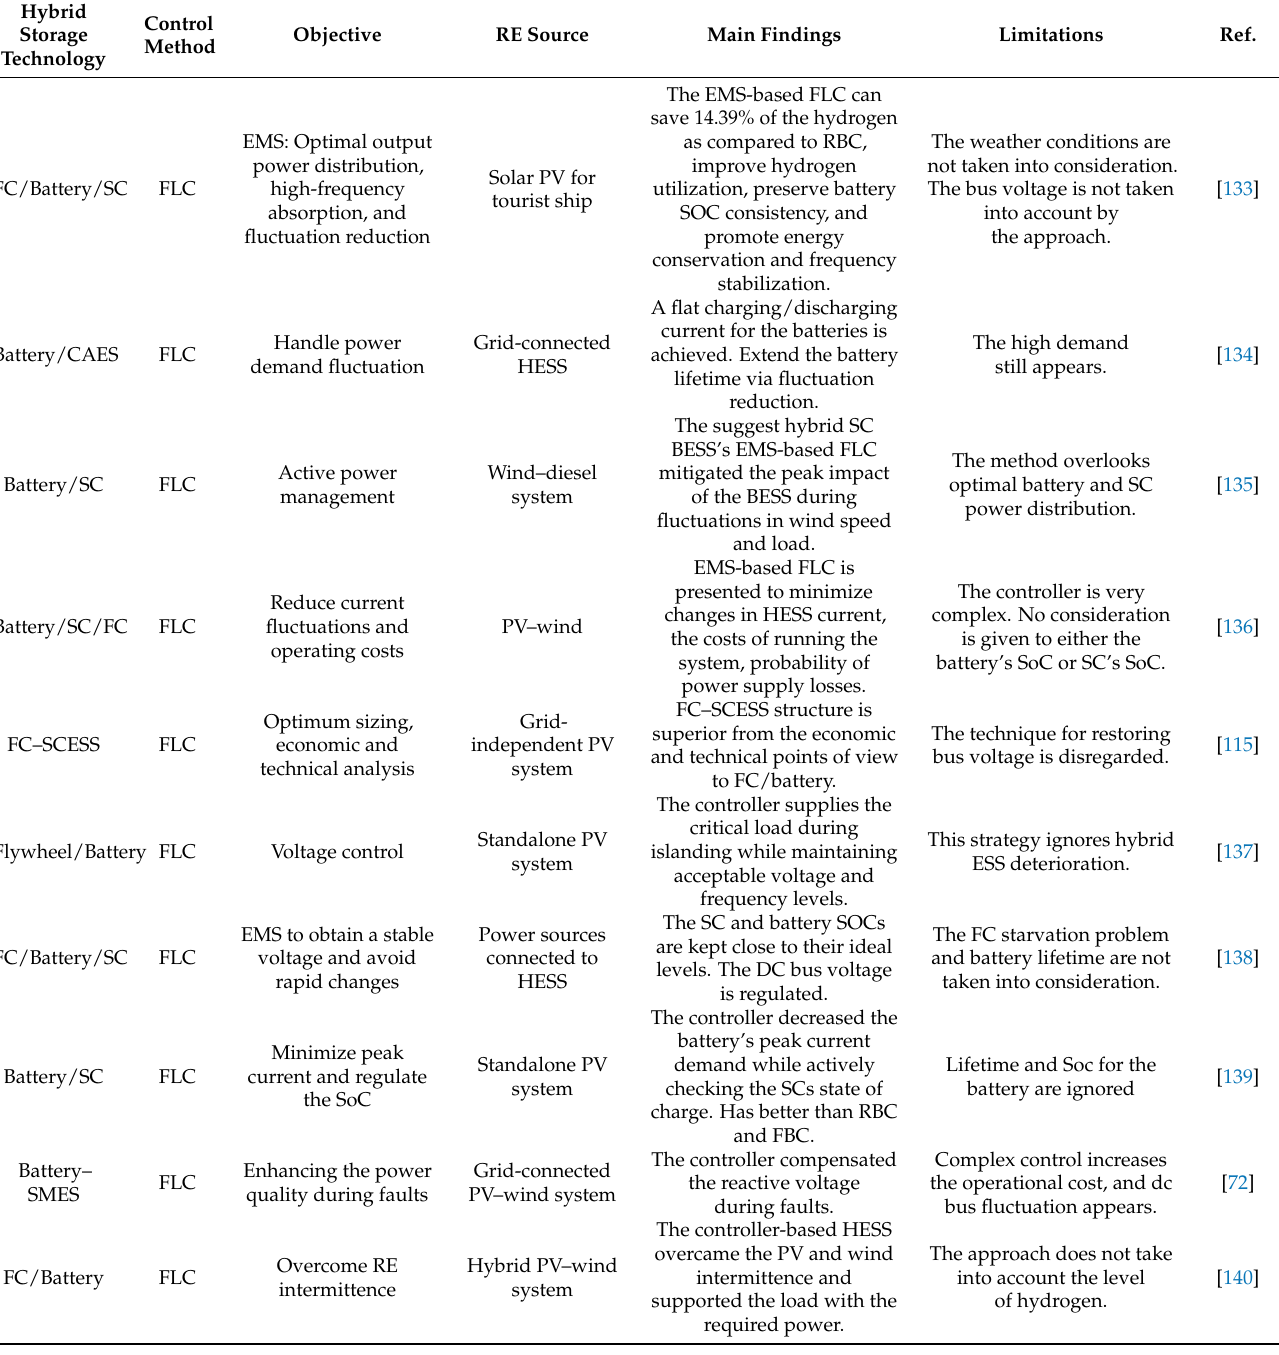
Table 5. The analysis of the common Intelligent control methods for HESS integrated RE